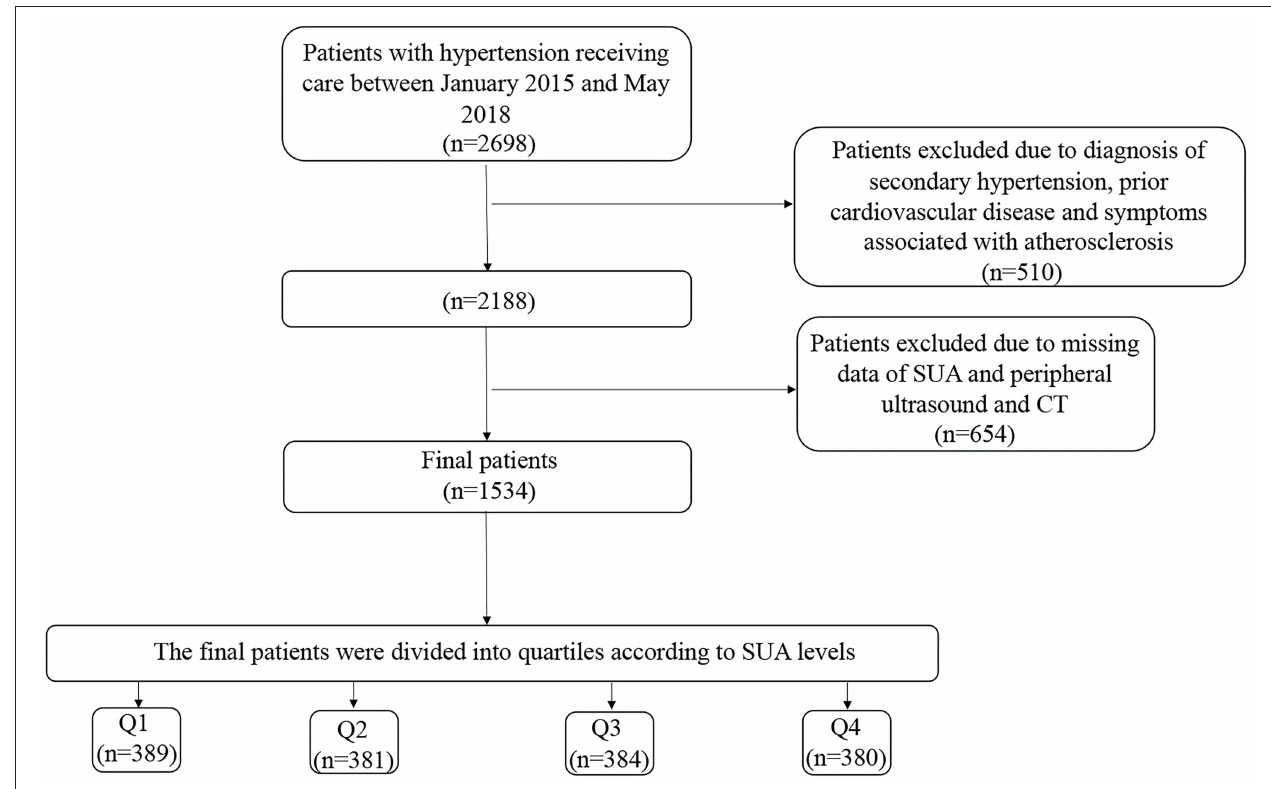
FIGURE 1 | Flow Chart of the participants. The quartiles of SUA concentration were calculated separately for men and women. SUA, serum uric acid; CT, Computed tomography.